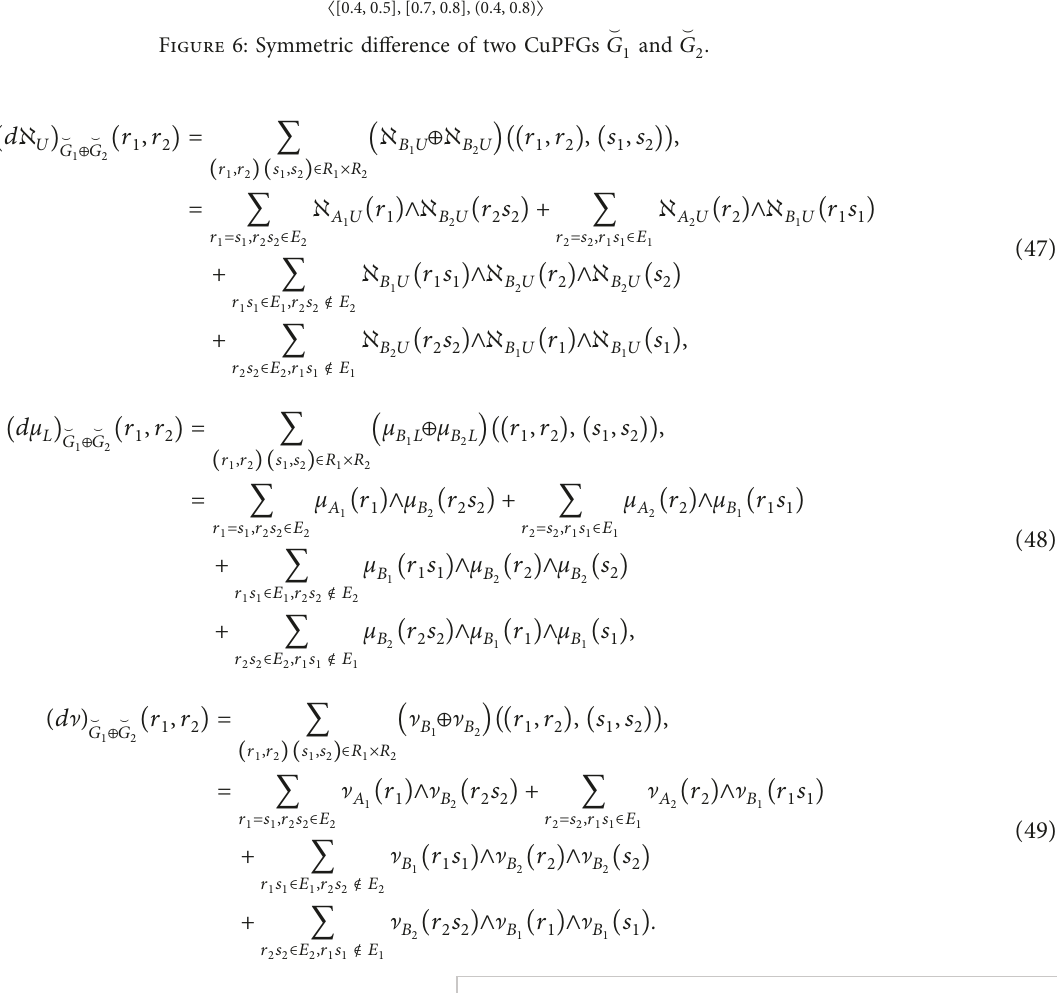
Figure 6: Symmetric difference of two CuPFGs G ⌣